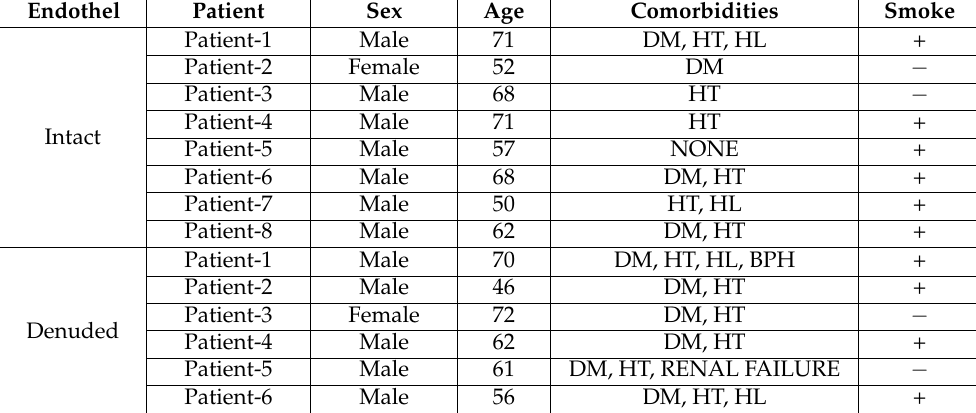
Table 1. Demographic data and comorbidities of patients. Age, sex, comorbidities, and smoking habit of the patients whose vein segments were tested. Patients divided into two groups according to endothelium integrity. (DM: diabetes, HT: hypertension, HL: hyperlipidemia, BPH: benign prostate